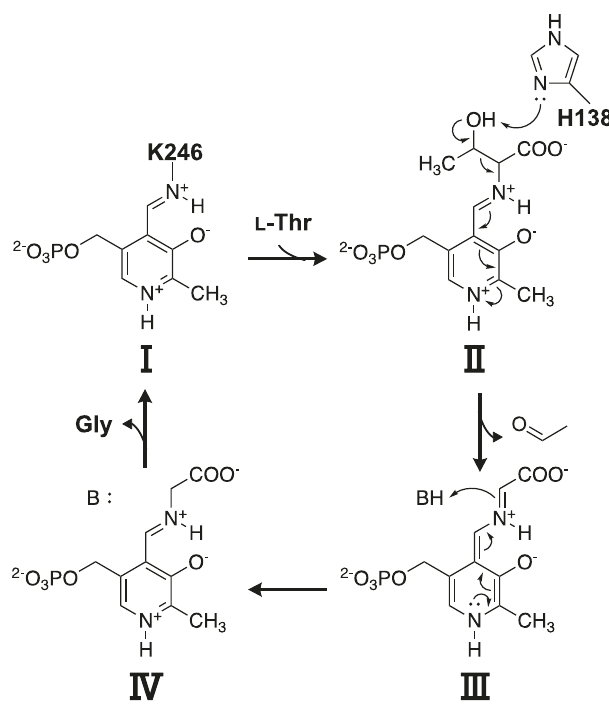
Fig. 6 Proposed TA reaction mechanism of CnKBL. I Indicates internal aldimine, ( II ) indicates external aldimine with L-Thr, ( III ) indicates quinonoid intermediate, and ( IV ) indicates external aldimine with Gly,